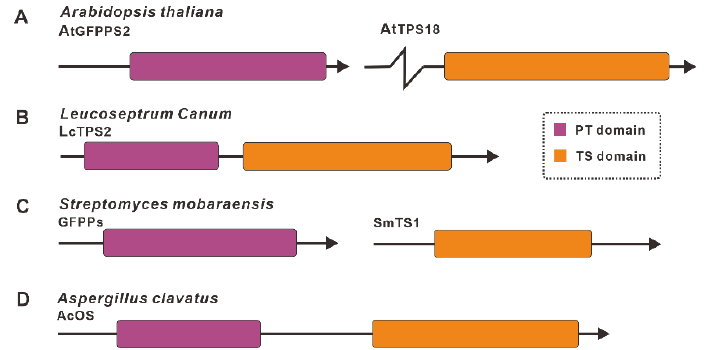
Figure 2. Schematic diagram of functional domains (PT and TS) associated with the biosynthesis of sesterterpene from plants ( A , B ), bacteria ( C ), and fungi ( D ). The prediction of functional domains was performed by PFAM (https://pfam.xfam.org (accessed on 1 September 2022)).